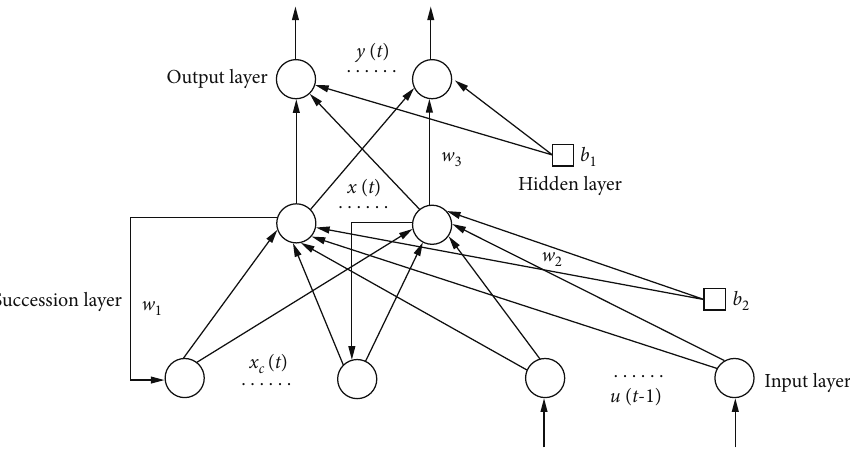
Figure 1: ENN network structure diagram.